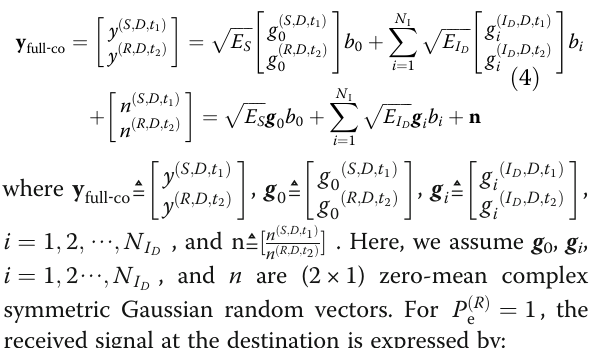
≥ β where β and β with β are the non-zero ordered 1 2 1 2 real eigenvalues of GG † and U is the (2 × 2) unitary ð s Þ is given matrix. The MGF M γ full ‐ co